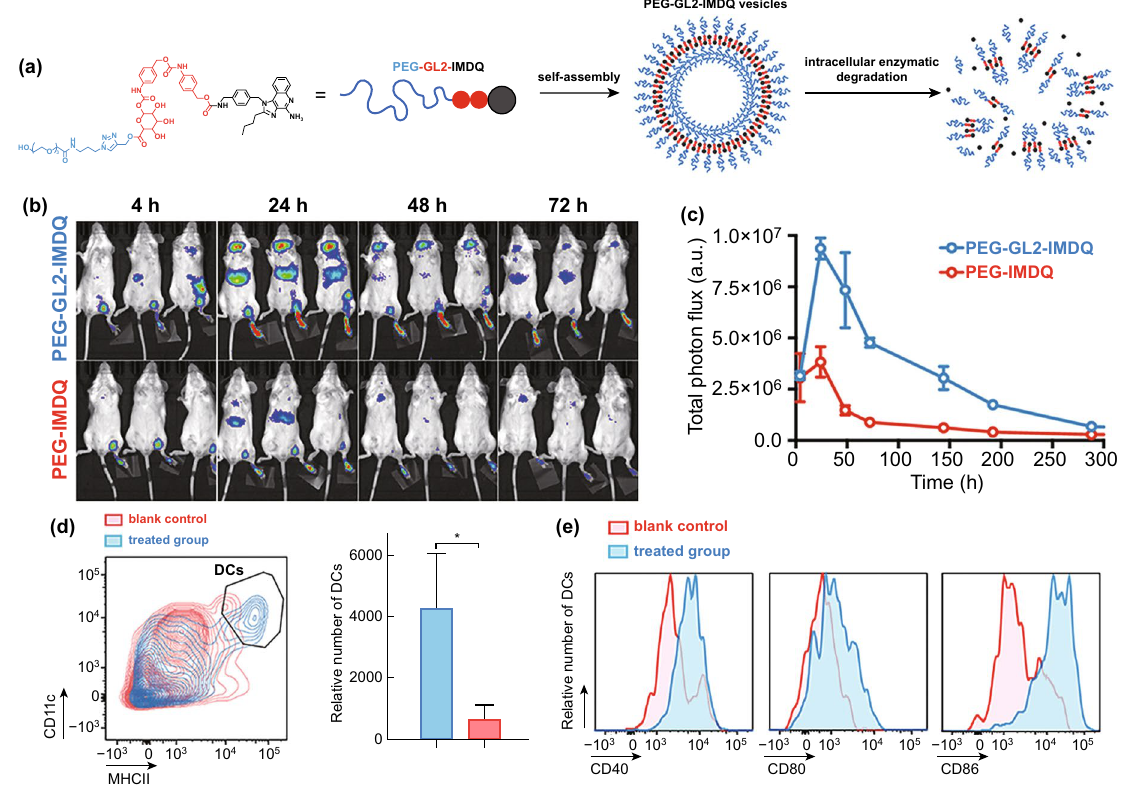
Fig. 3 a Schematic representation of the fabrication of IMDQnano: block copolymers composed of mTEGMA and PFPMA self-assemble in DMSO into micellar nanoparticles driven by solvophobic interaction between PFPMA moieties. Covalent IMDQ-ligation, cross-linking with a pH-sensitive cross-linker, and transformation of unreacted PFP esters into hydrophilic repeating units yield stable hydrogel nanoparticles that can disassemble into soluble polymers in response to an acidic pH. b Size distribution measured by DLS and IMDQ loading of IMDQnano and empty nanoparticles. c TEM images of IMDQnano and empty nanoparticles. d Tumor growth of B16 tumors in mice, in response to treat- ment monotherapy and combination therapy (n = 6). e Confocal microscopy image of a tissue section collected from a B16 tumor treated with IMDQnano, anti-PDL1, and Flt3L combination immunotherapy. f Confocal microscopy image of a tissue section collected from a B16 tumor treated with PBS control. Reproduced with permission from Ref.